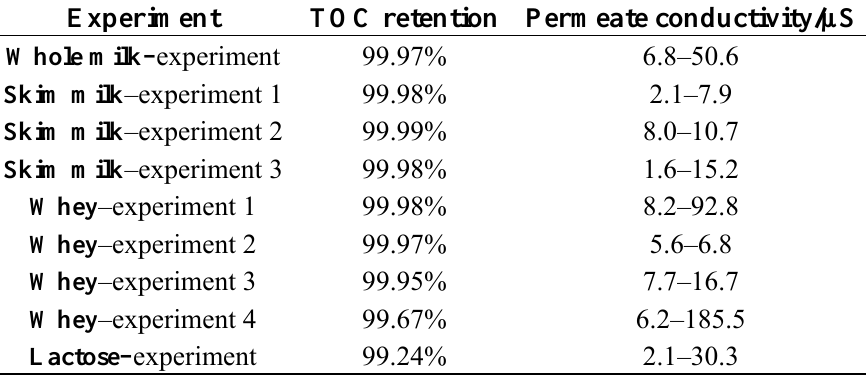
Table 1. TOC-retention at end of experiments and permeate conductivity at beginning and end of